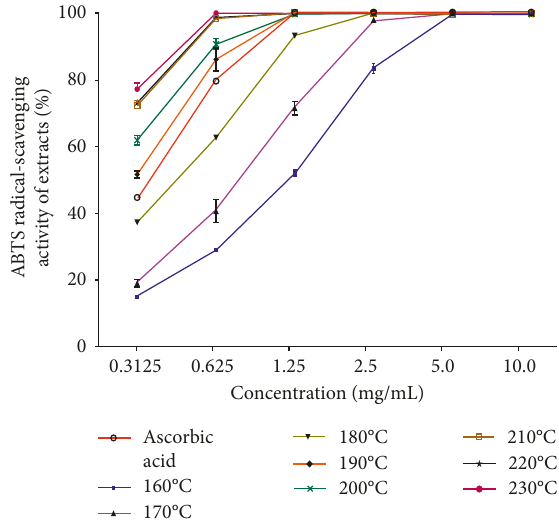
standard deviation of trip- ±